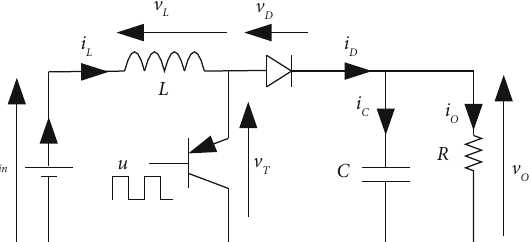
Figure 4: Circuit diagram of DC/DC boost converter.